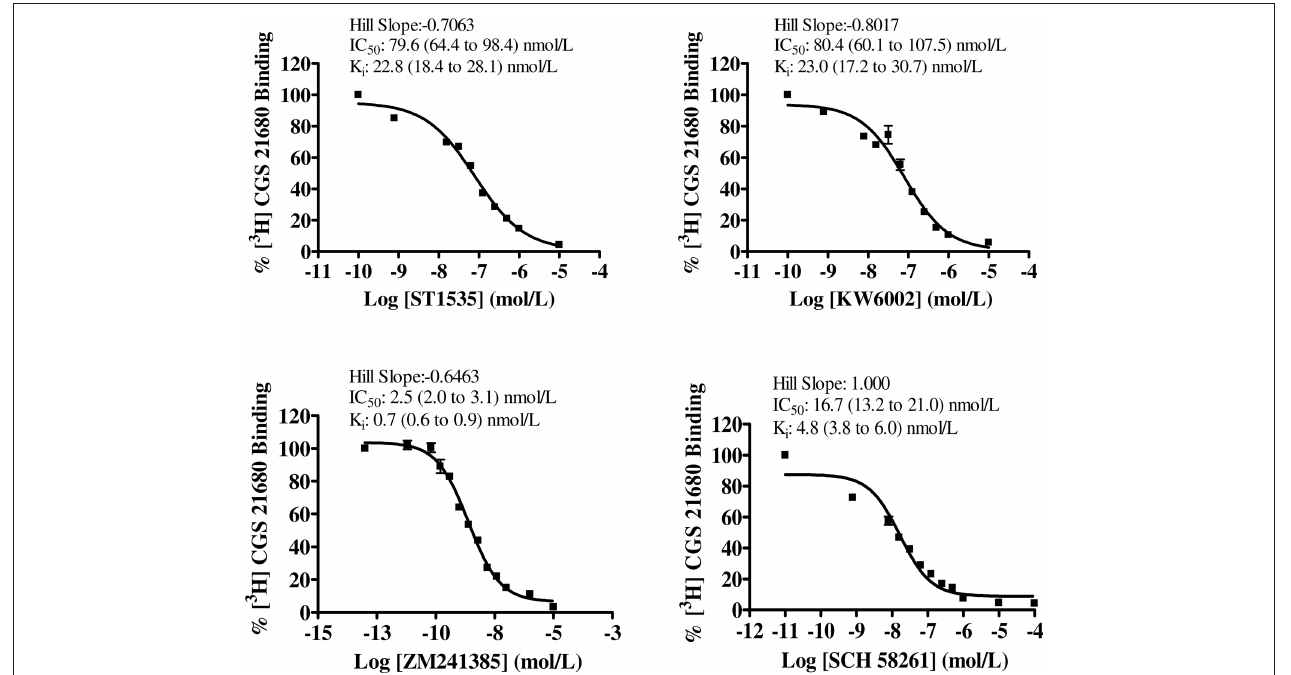
of compounds. Non-specific binding was determined with 100 μM 2-chloroadenosine. Curves were obtained from 3 to 4 independent experiments performed in duplicate. Values in brackets represent 95% confidence